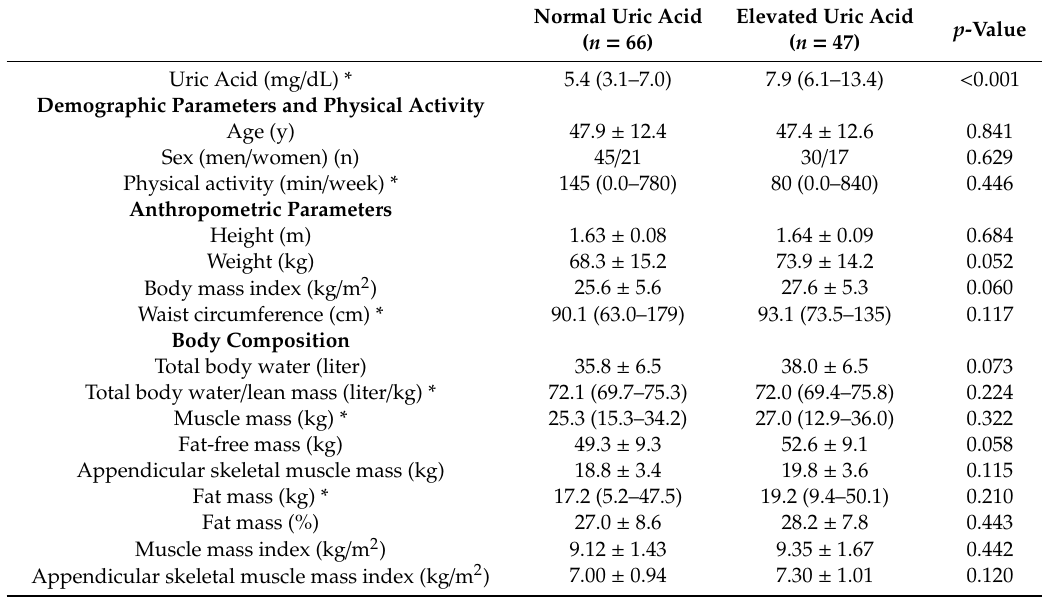
Table 1. Characteristics of the participants according to uric acid